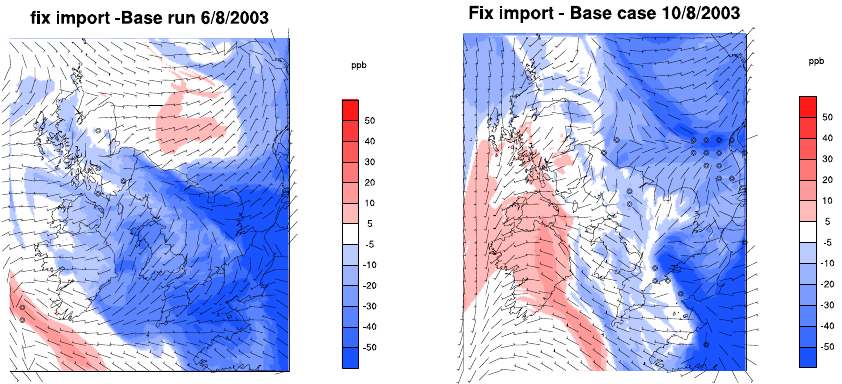
Fig. 18. Change in simulated surface daily maximum ozone (ppb) relative to the base case scenario for the sensitivity experiment with fixed (climatological) boundary condition for O 3 , for 6 and 10 August 2003. The 12:00 10m wind is also shown.